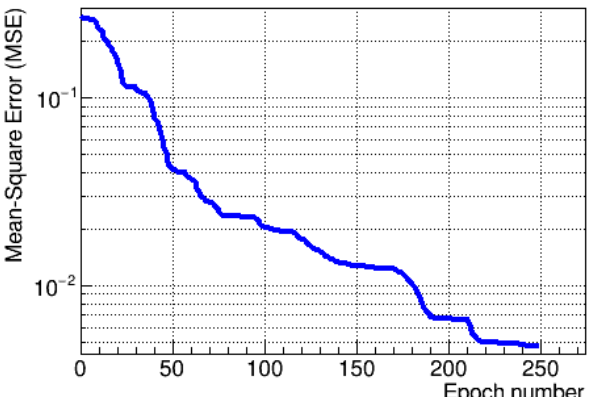
Figure 5. The gradient descent for the training process of the neural